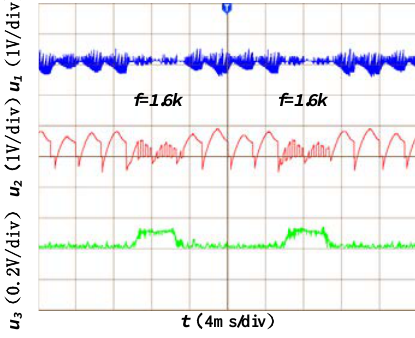
Figure 28. Voltage waveforms.